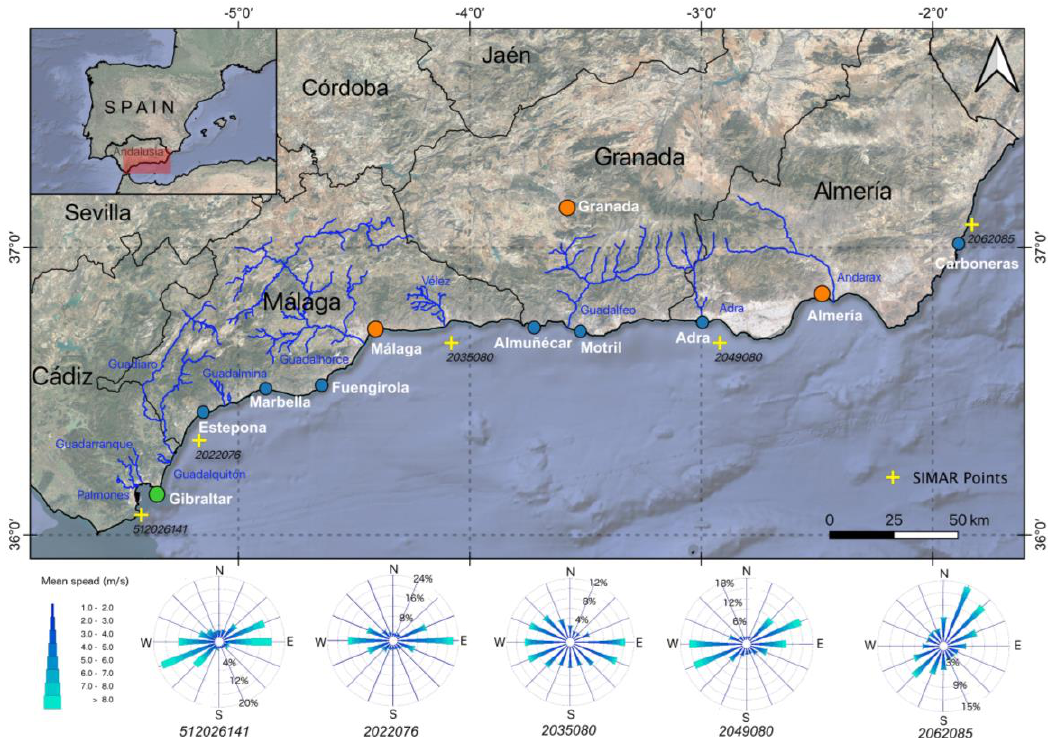
Figure 1. Location of the study area and average wind speed roses at 5 points of SIMAR (SImulación MARina), from the wave reanalysis model by Puertos del Estado (PdE).